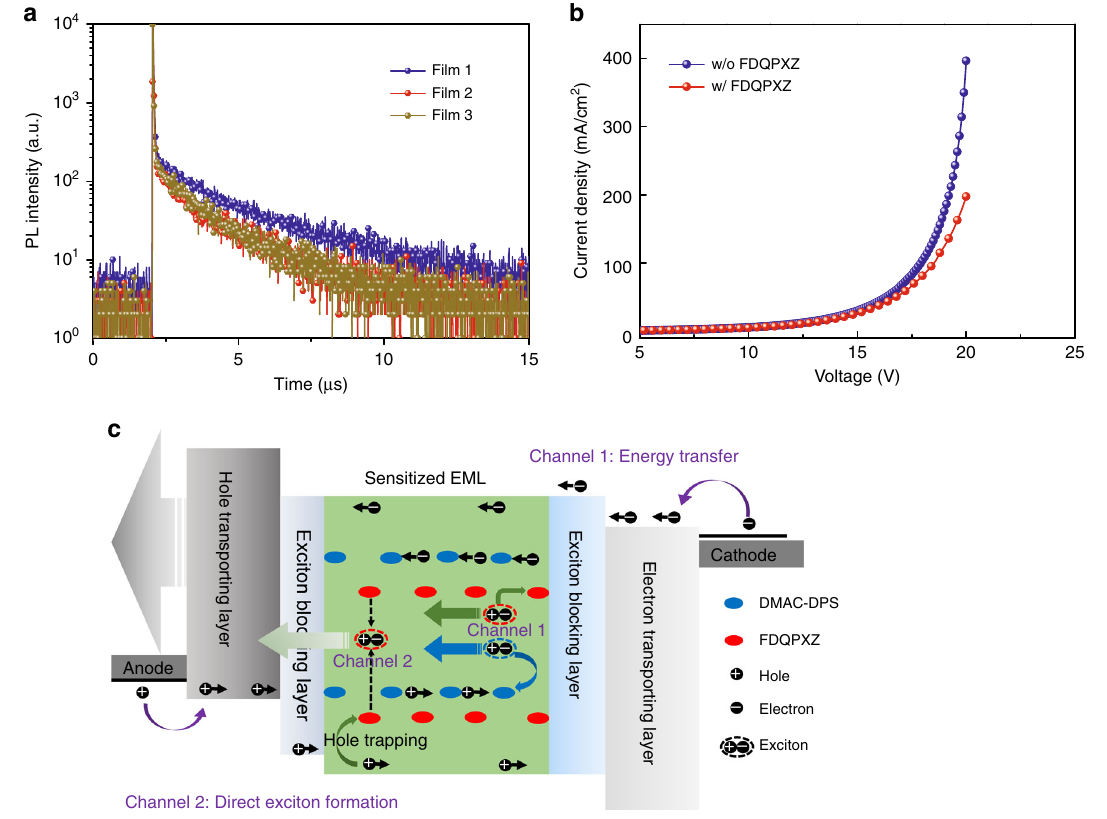
Fig. 4 Work mechanism of the proposed devices . a Transient photoluminescence decay curves measured at 470 nm with an excitation wavelength of 350 nm. Film 1 consists of DPEPO:30% DMAC-DPS (20 nm); fi lm 2 is DPEPO:30% DMAC-DPS:0.5% FDQPXZ (20 nm); fi lm 3 is DPEPO:30% DMAC-DPS:1% FDQPXZ. b Current density – voltage ( J – V ) characteristics of the hole-only device with the structure of ITO/HATCN (10 nm)/TAPC: HATCN (20 wt%, 50 nm)/TAPC (20 nm)/DPEPO:25% DMAC-DPS (20 nm) or DPEPO:25% DMAC-DPS:1.0% FDQPXZ (20 nm)/TAPC (20 nm)/TAPC: HATCN (20 wt%, 50 nm)/HATCN (10 nm)/Al. c Illustrated schematics of the work mechanism consisting of two parallel channels: ef fi cient